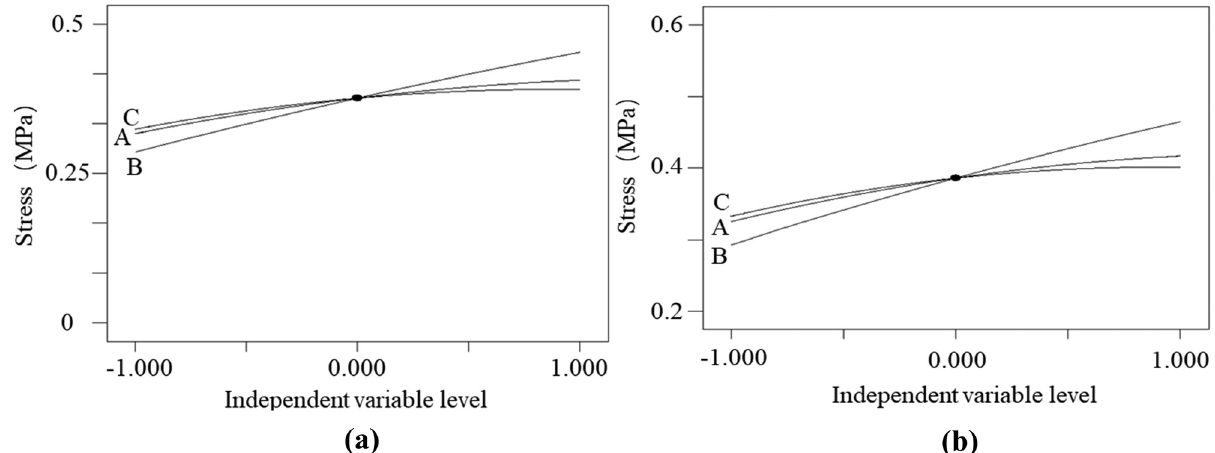
Figure 3: Analysis of single factor impact: ( a ) σ 1 analysis of single factor impact and ( b ) σ 2 analysis of single factor